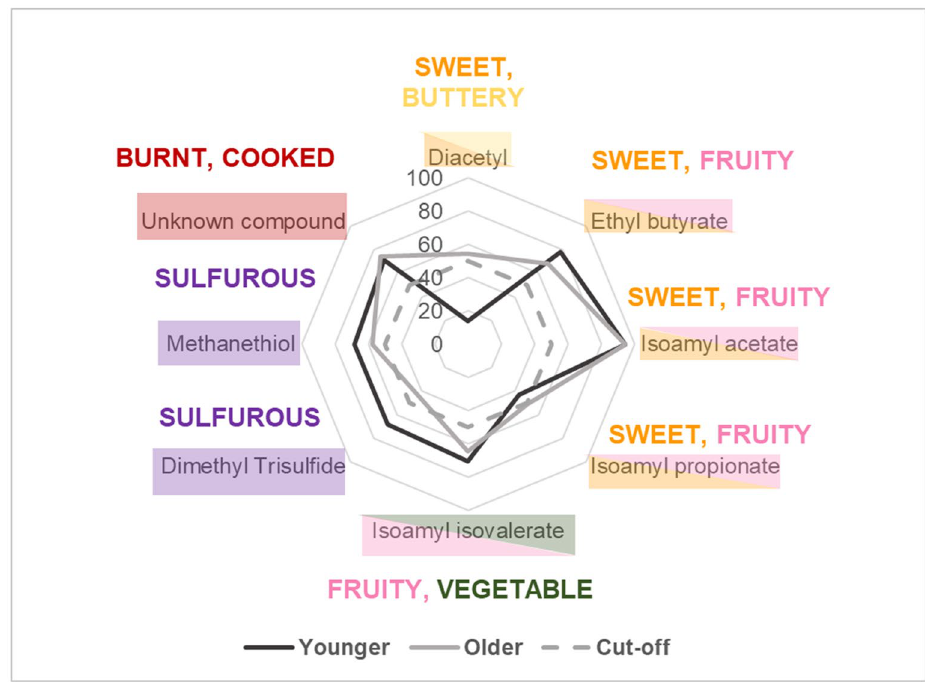
Figure 3. Modified frequency values (%) of younger participants (n = 6, black) and older participants (grey, n = 6). The 50% cut off value is